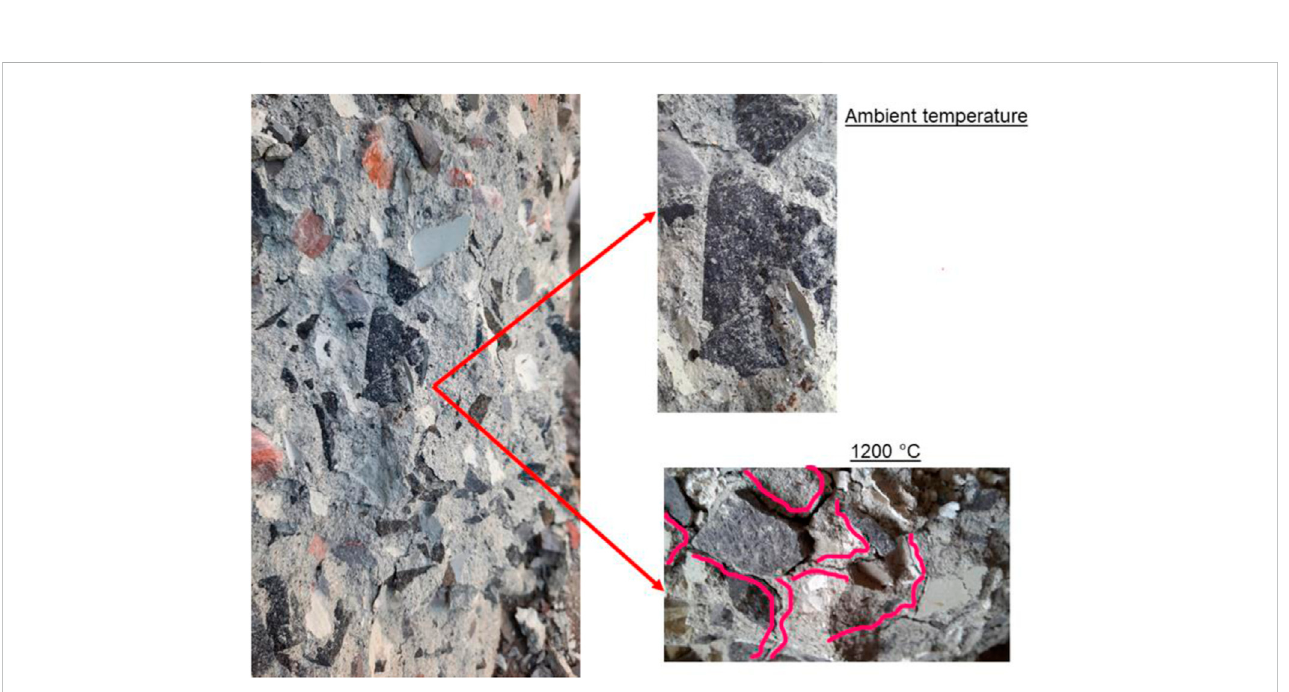
FIGURE 6 Delamination of DHA aggregates in Dolerite mix (D3) after exposed to 1200 ° C.